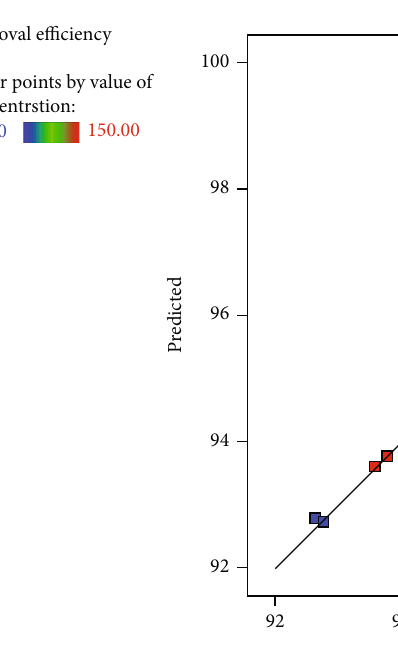
Figure 5: The plot of the predicted values versus the observed values of CEX adsorption on Fe